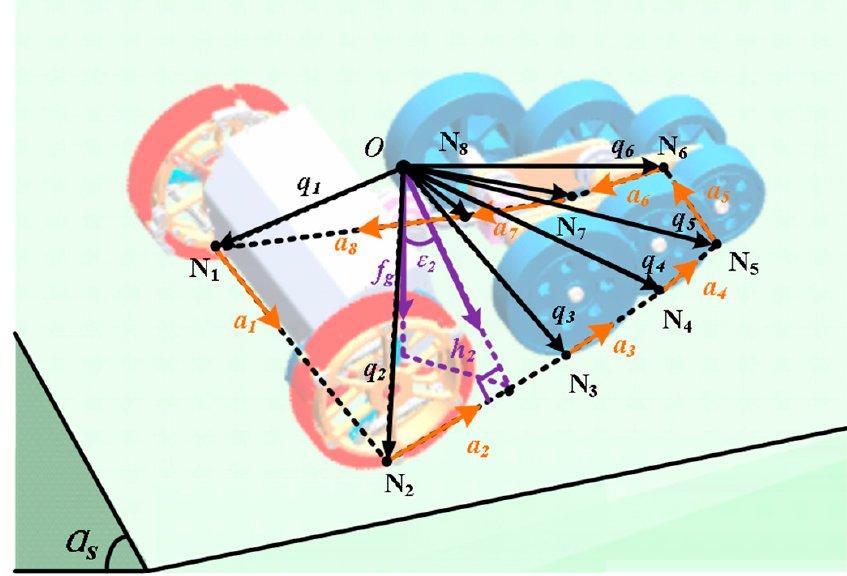
Figure 13. Slope stability model.